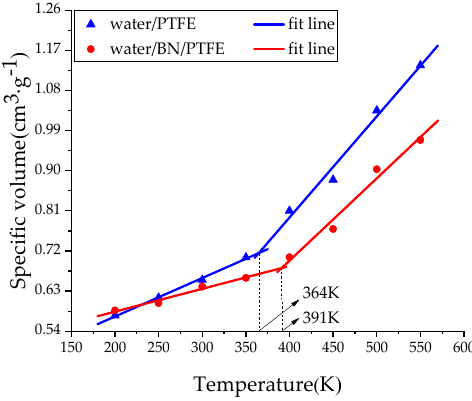
/ PTFE and water / BN / PTFE Figure 3. Determination of T g for water/PTFE and water/BN/PTFE models. Figure 3. Determination of T g for water Figure 3. Determination of T g for water/PTFE and water/BN/PTFE models.